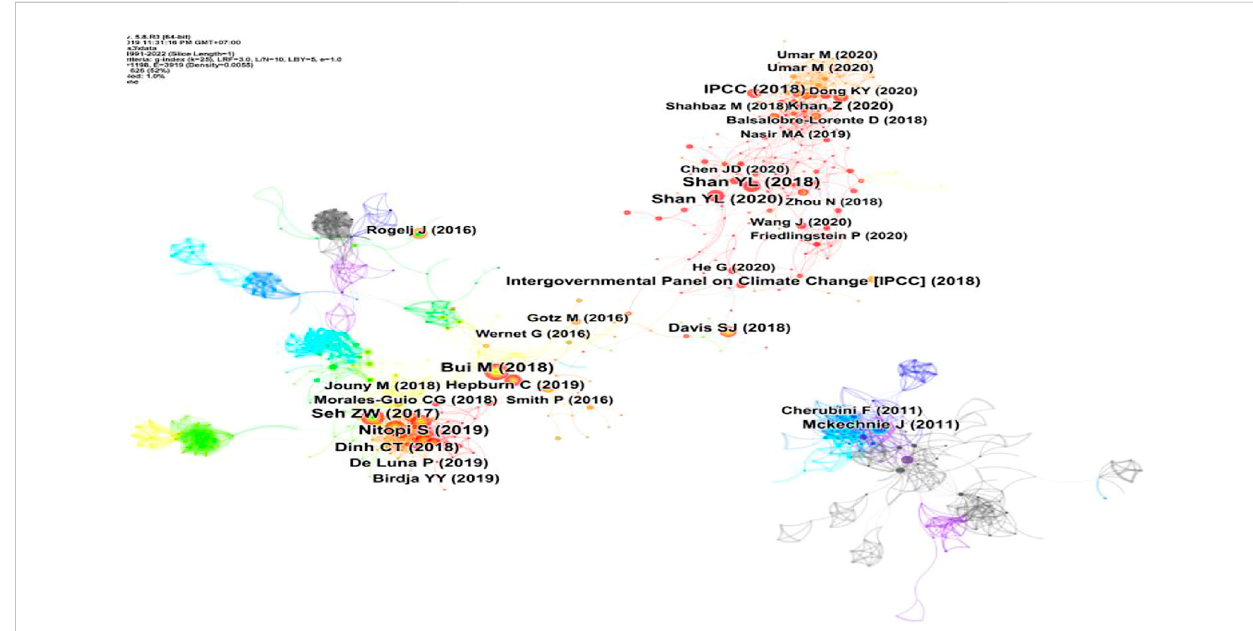
FIGURE 3 Statistical analysis of highly co-cited literature.